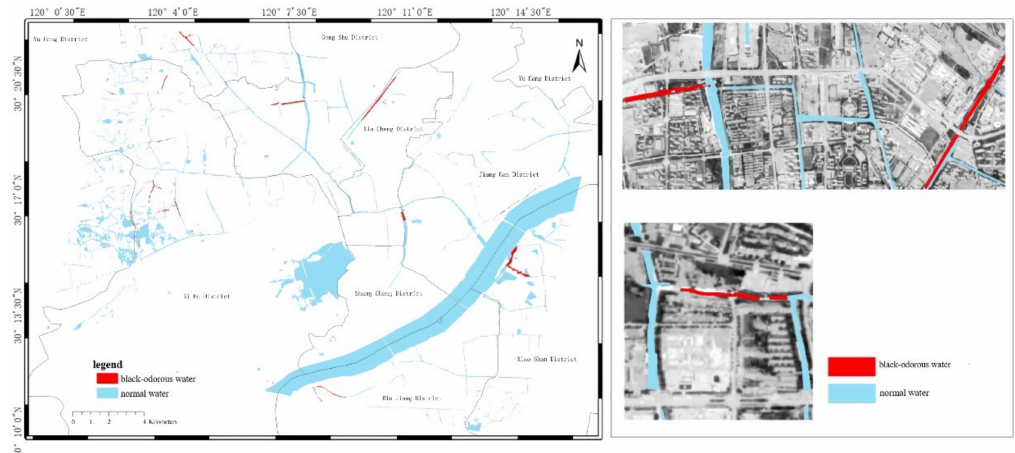
Figure 13. Distribution map of black-odorous water in